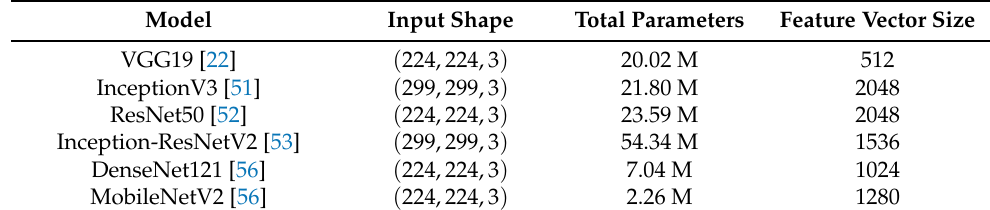
Table 2. Deep CNN feature extractors.